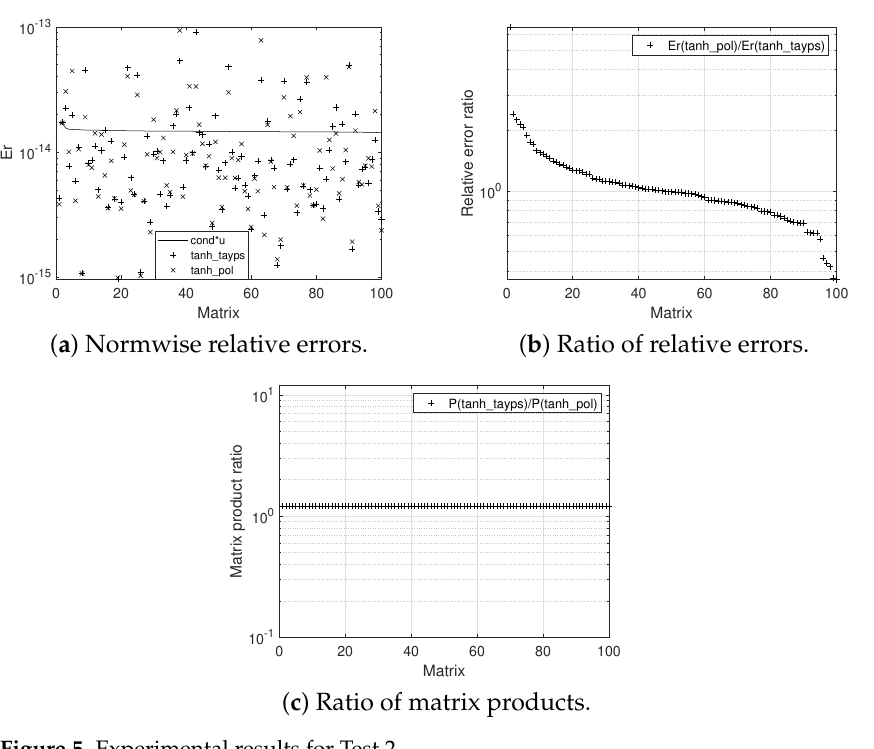
Figure 5. Experimental results for Test 2.